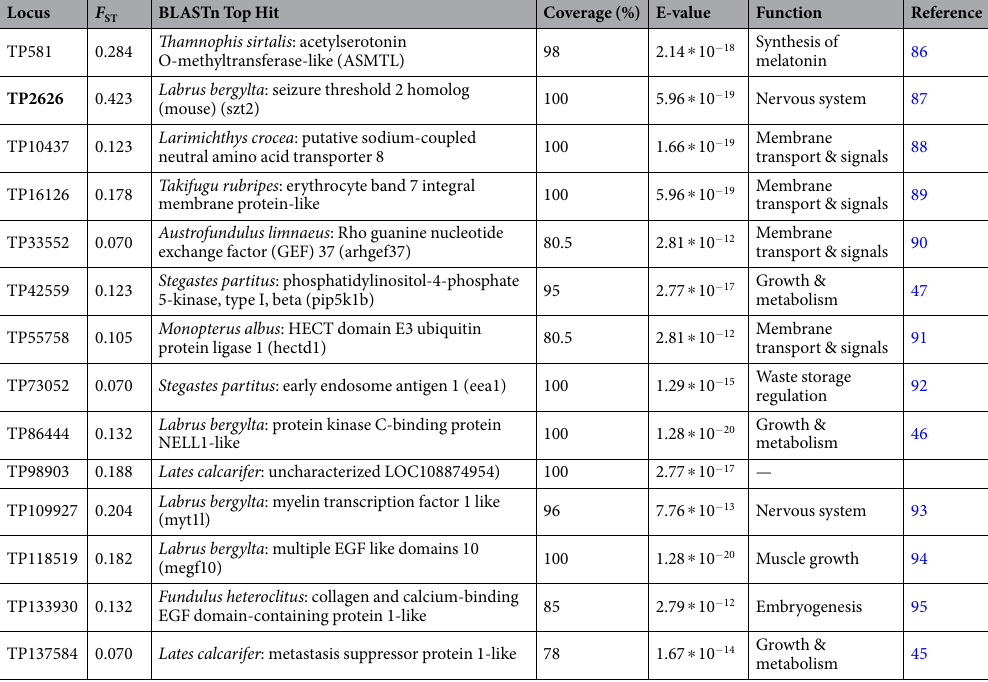
Table 2. List of outlier loci selected from BLASTn results together with alignment information: locus name, genetic differentiation ( F ST ), BLASTn top hit, sequence coverage (%) and e-value. Also shown is the physiological function associated with each top hit and a reference. Only top hits with ≥ 50% coverage and ≤ e − 10 were selected during BLASTn. Bold typeface indicates outlier loci that were identified via LOSITAN, BAYESCAN and BAYESCENV